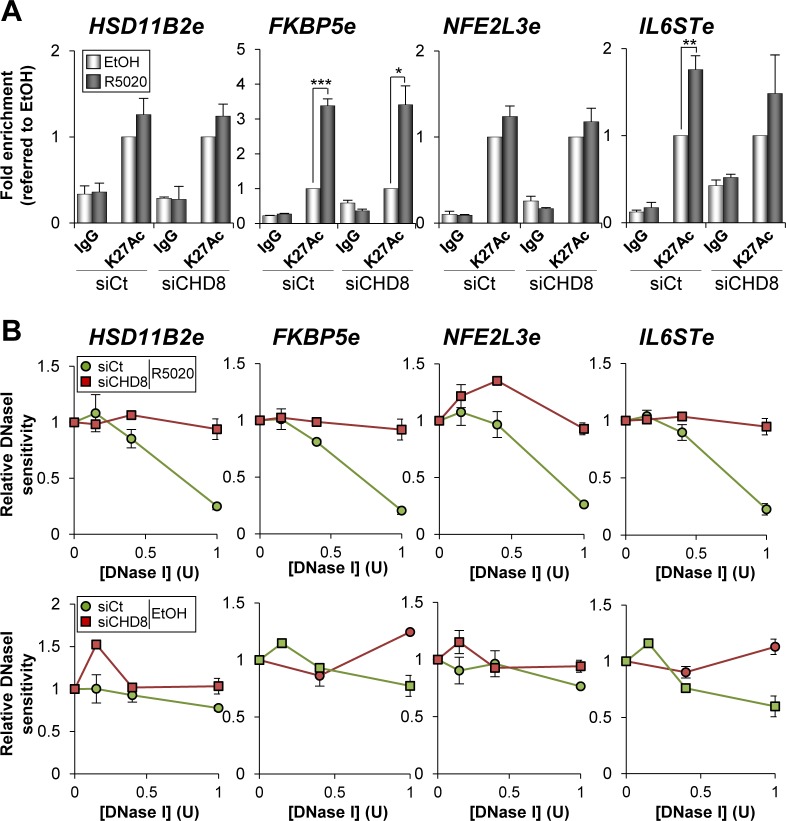
CHD8 involvement in modification of enhancer chromatin.(A) CHD8 is not required for H3K27 acetylation. ChIP analysis of H3K27Ac enrichment at the indicated enhancers in T47D-MTVL cells transfected with control siRNA (siCt) or siRNA against CHD8 (siCHD8), and then stimulated with R5020 (R5020) or vehicle (EtOH) for 45 min. Data are the mean of at least n = 6 qPCR reactions from three independent experiments. Error bars represent ± SD values. * p < 0.01; ** p < 0.001; *** p < 0.0001 using Student’s t-test. (B) CHD8 contributes to open chromatin at PR enhancers. DNase I sensitivity at the indicated regions in T47D-MTVL cells transfected with control siRNA or siRNA against CHD8, and then stimulated with R5020 or vehicle for 45 minutes. Error bars represent ± SD (n = 3).